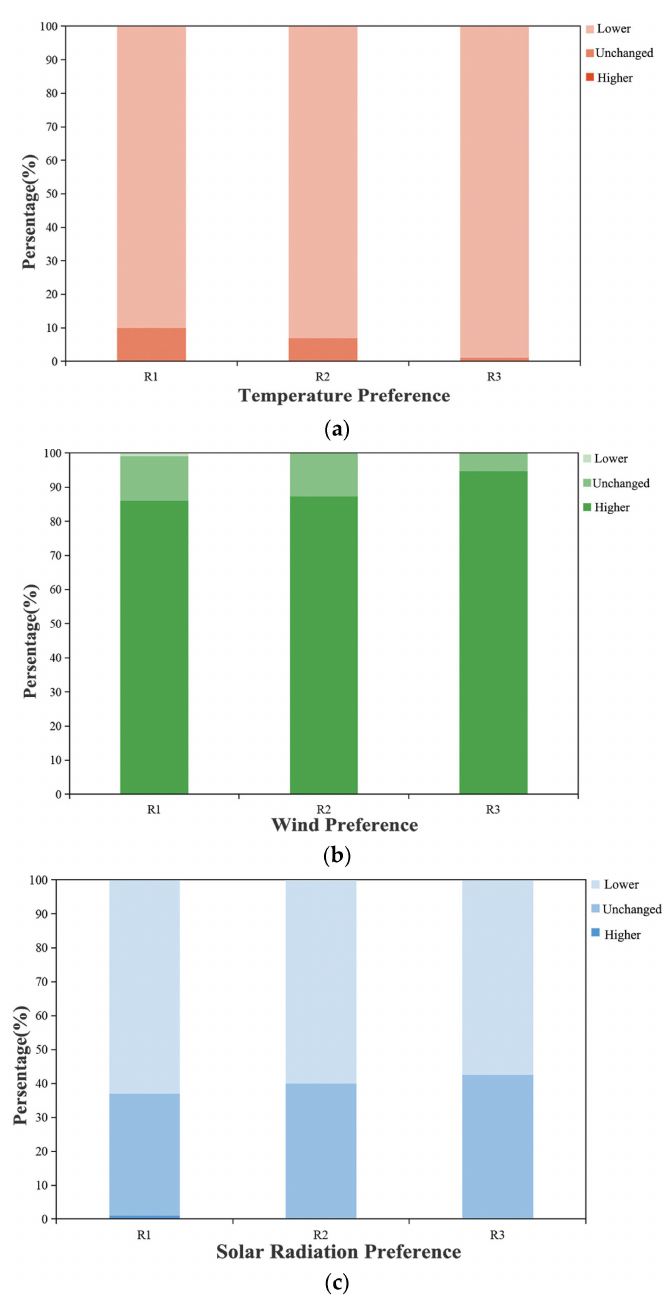
Figure 6. Preference votes for meteorological factors in the three different measuring points: ( a ) Ta (air temperature), ( b ) V (wind speed), ( c ) G (global